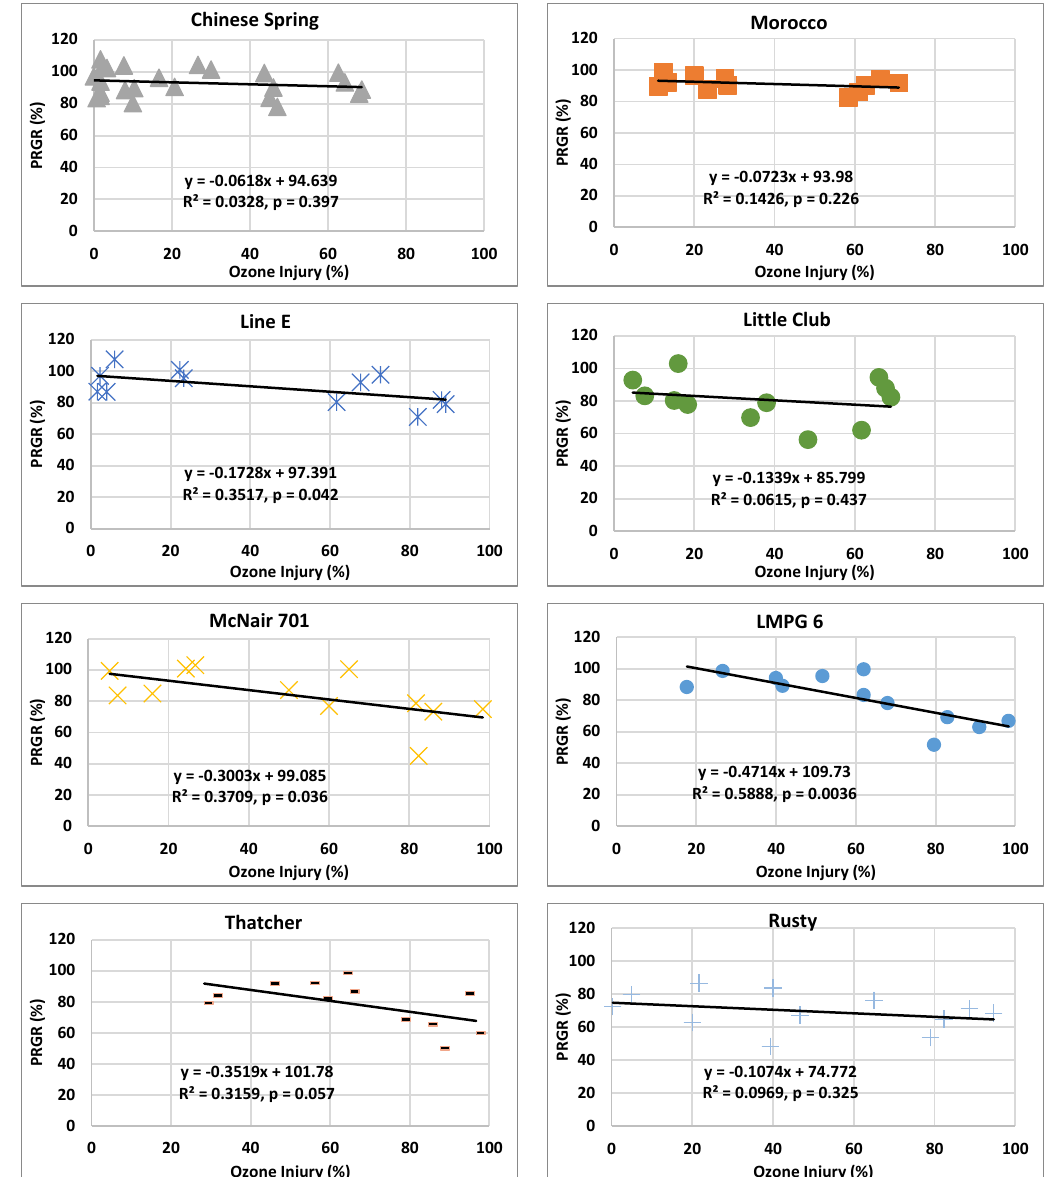
Figure 17. Relationship between percent relative growth rate (PRGR) and O 3 injury on third–fifth leaves of each of the eight rust near-universal susceptible genotypes at three different O 3 levels of 50, 70, and 90 ppb (12 h/day, at 25 °C and 50% RH, for 14 days in OPECs). PRGR is the percentage of RGR of each plant referenced to the genotype’s average RGR in charcoal-filtered air (O 3 = 5 ppb).